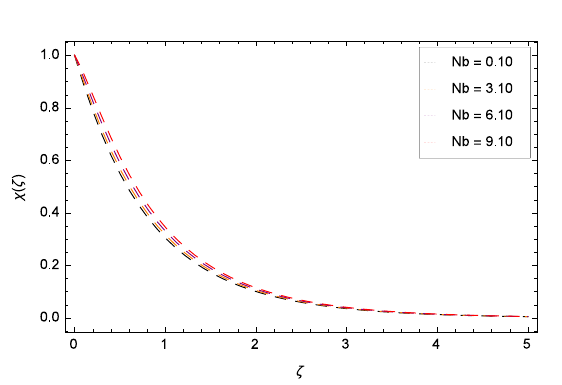
Figure 23. Pattern of graph curves on account of Nt .